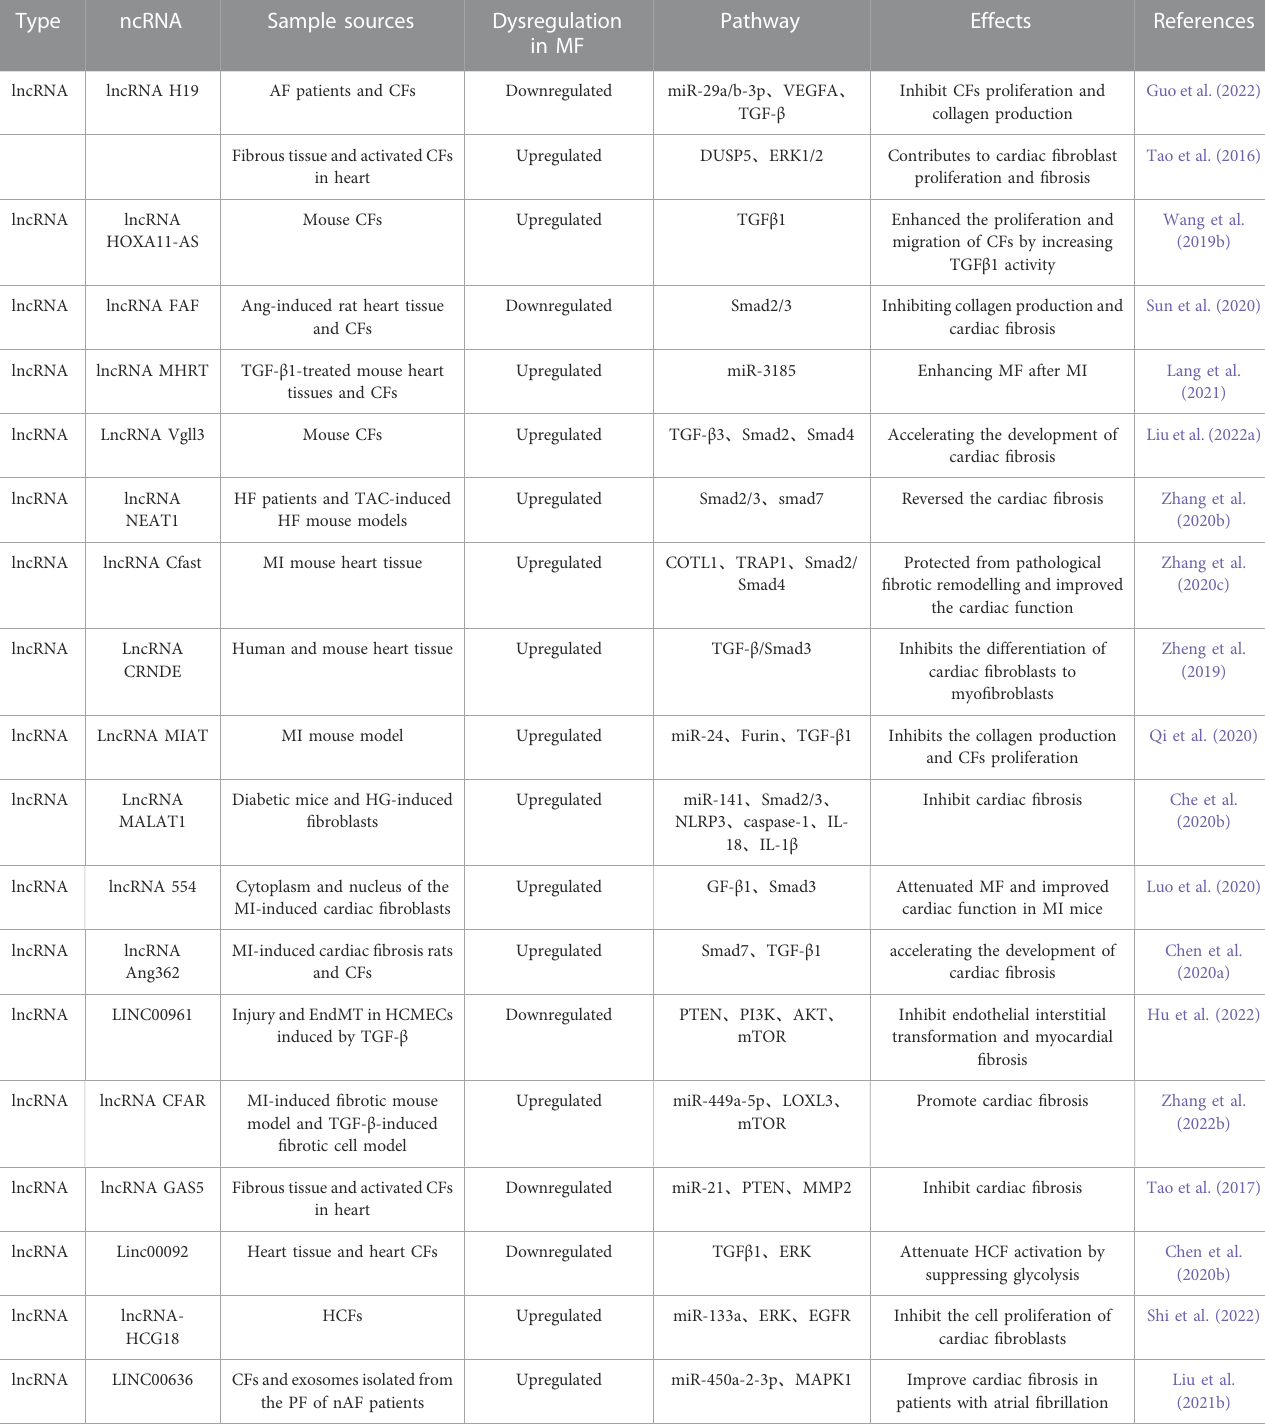
TABLE 2 Mechanism of lncRNA regulating TGF signaling